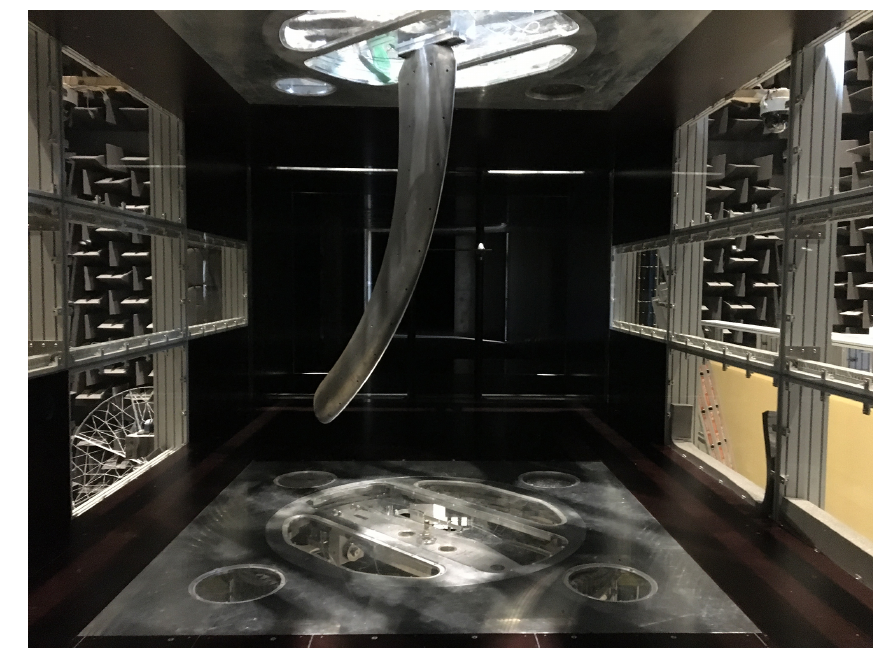
Figure 6. The tip model mounted in the test section of the Poul la Cour wind tunnel. Table 1. Test configurations. Tripped; zz tape (zz: turbulator zigzag tape; 0.205mm height, 6mm wide, 70 ◦ along the entire span) at 5%c on the suction side and 10%c on the pressure side, where c is the local chord